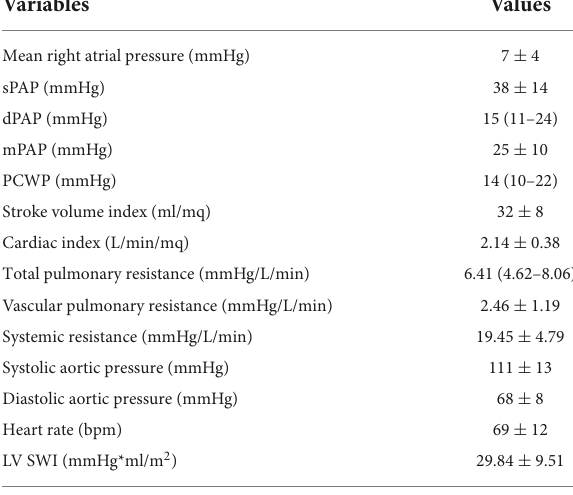
TABLE 2 Echocardiographic parameters. TABLE 3 Right heart catheterization parameters.